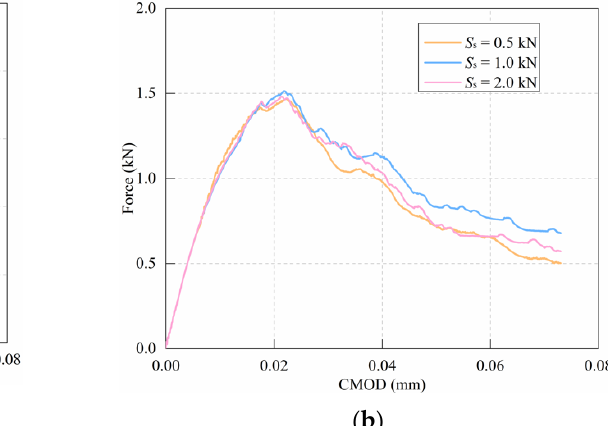
( b ) Figure 13. Effect of stiffness: ( a ) normal stiffness; ( b ) shear stiffness. Figure 13a shows that the ascending segment of the curve becomes steeper as the normal stiffness increases. The peak value increases as the normal stiffness ( n k ) increases as well. Figure 13b shows that raising the shear stiffness ( s k ) has the same tendency as